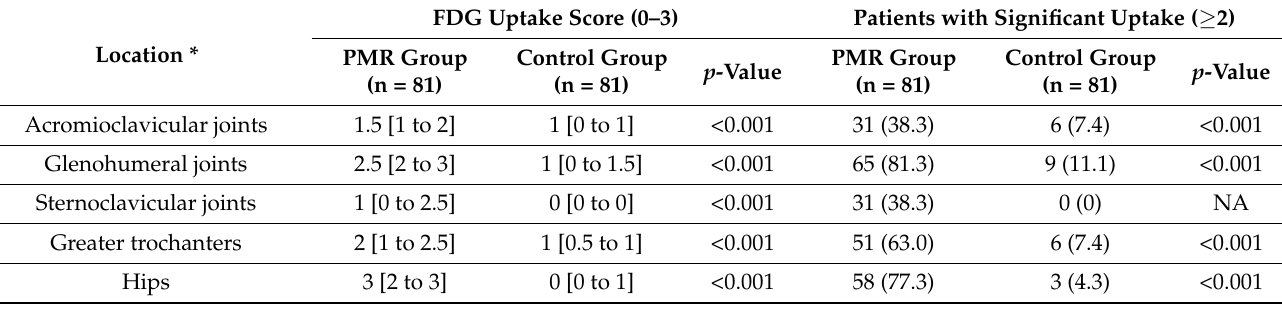
Table 3. FDG-PET/CT results according to